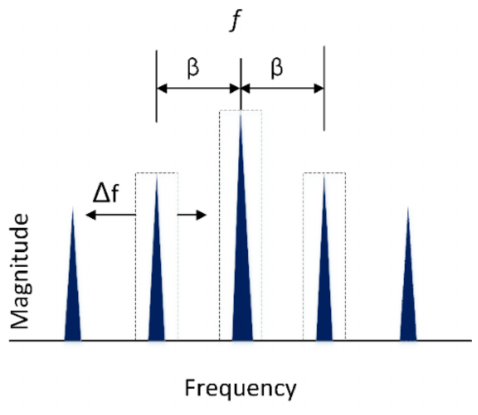
Figure 4. The process of the sideband